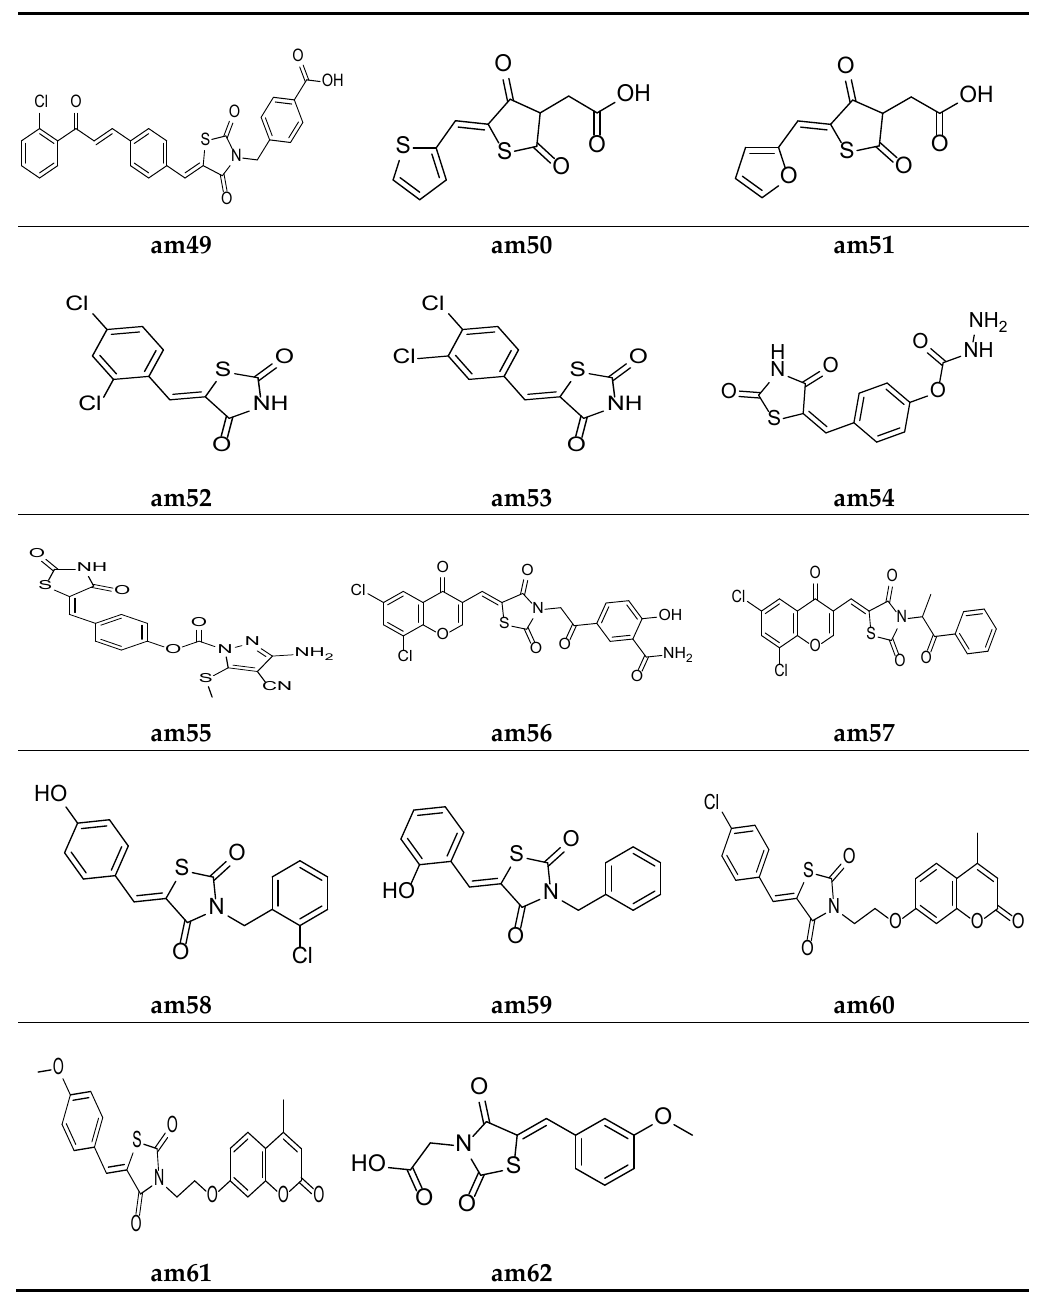
Figure 13. Molecular structures of the compounds (am49–am62). Table 23. Antimicrobial activity (MIC = µ g/mL) of the compounds ( am50 – am51 ).